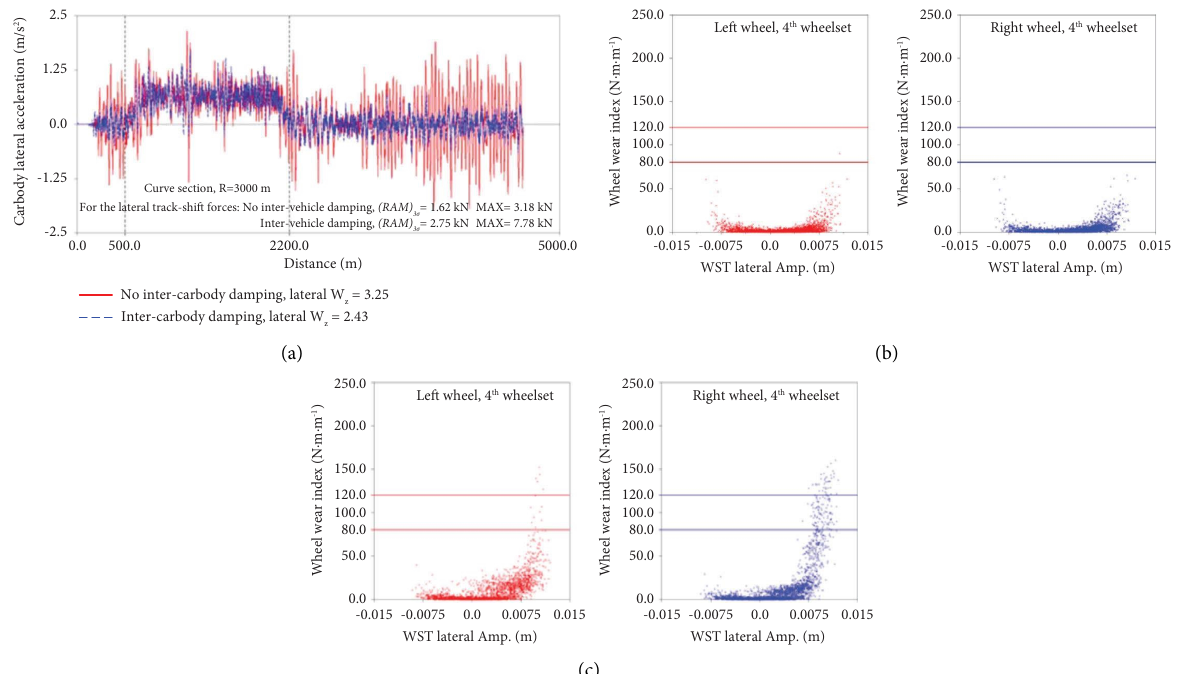
Curve section, R=3000 m For the lateral track-shif forces: No inter-vehicle damping, (RAM) 3σ = 1.62 kN MAX= 3.18 kN